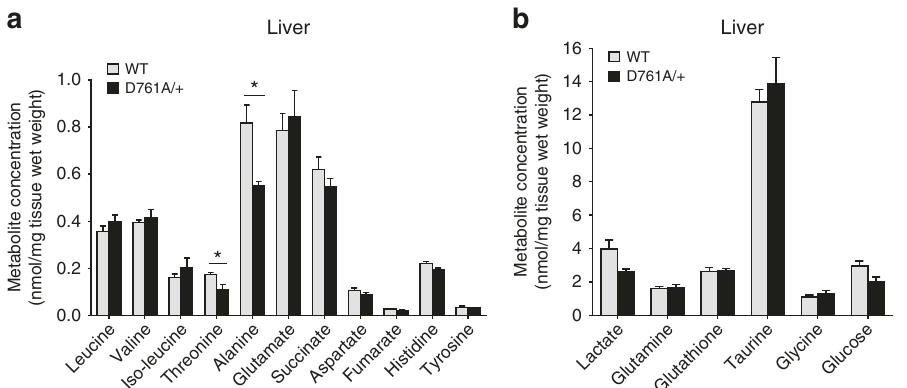
Fig. 8 Metabolite concentration in fasted liver. a , b Livers from overnight-fasted mice were collected, snap-frozen and processed for NMR analysis. Data represent mean ± SEM (non-parametric Mann – Whitney t -test). 4 – 5 mice/genotype. * p < 0.05, ** p ≤ 0.01, *** p ≤